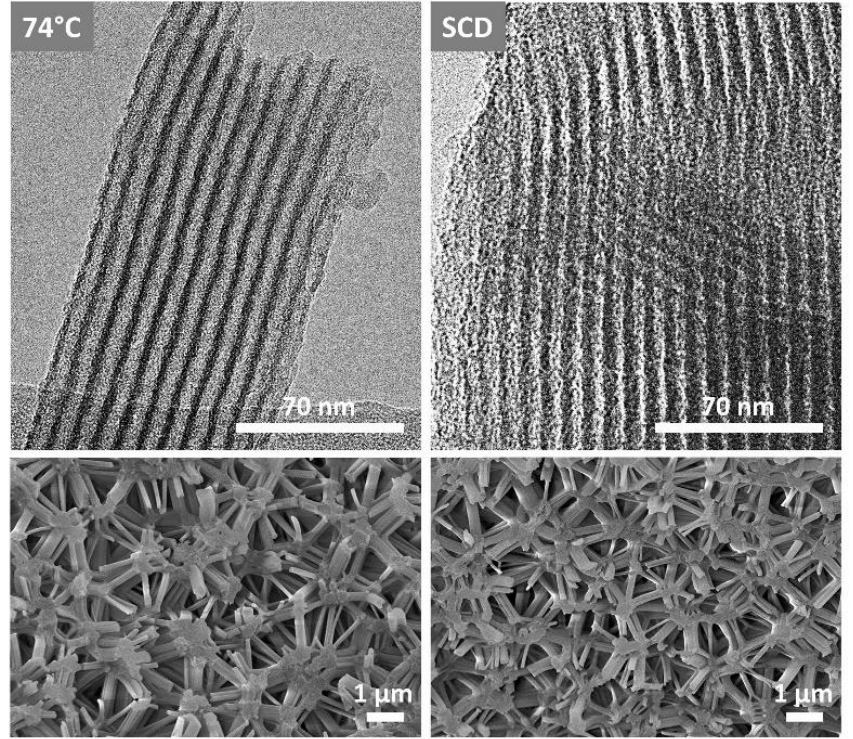
Figure 2. TEM ( top ) and SEM ( bottom ) images of differently dried silica monoliths shown for evaporative drying at 74 °C ( left ) and supercritical drying ( right ).